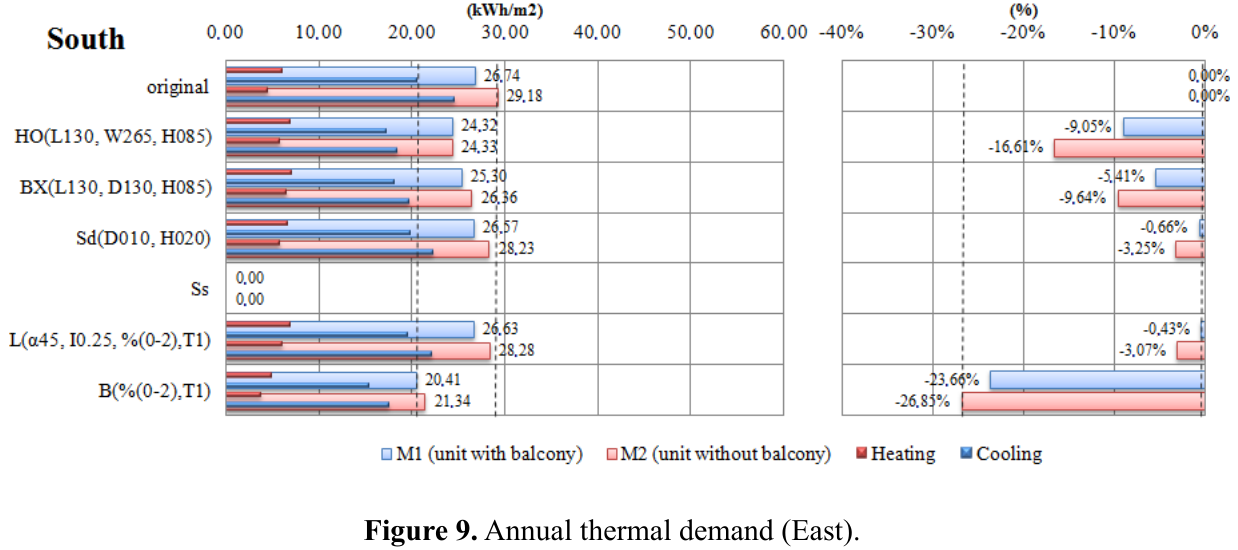
Figure 9. Annual thermal demand